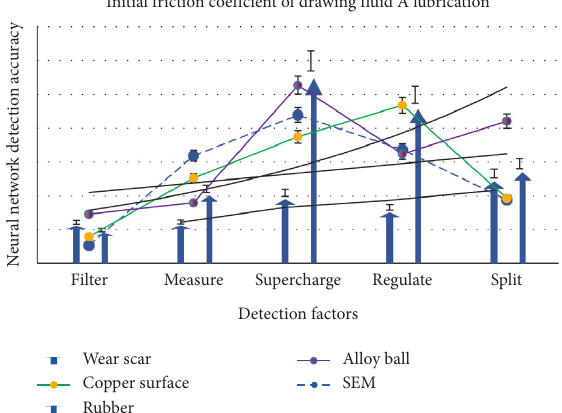
Figure 4: Initial friction coefficient of drawing fluid A lubrication.